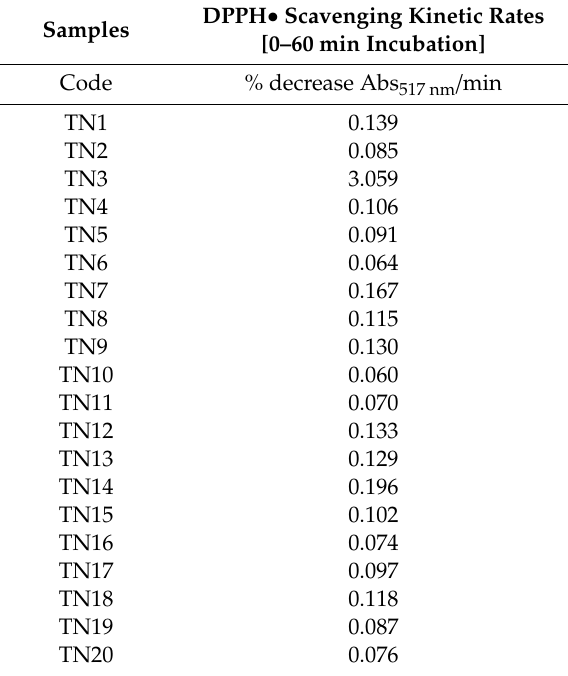
Table 2. Zero-order kinetic rates of DPPH • radical scavenging by tannins over a 60-min incubation